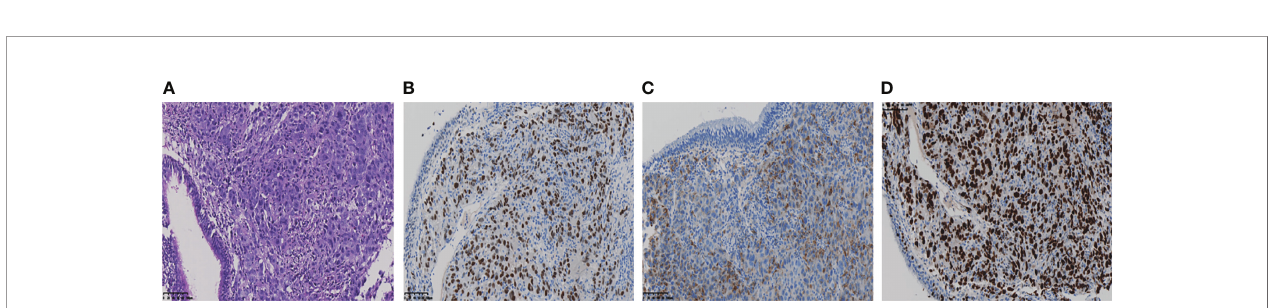
FIGURE 2 | (A) The pathological diagnosis of the biopsy was lung adenocarcinoma. (B, C) Immunohistochemistry staining: TTF-1, Napsin A, was positive respectively. (D) Ki-67 score was